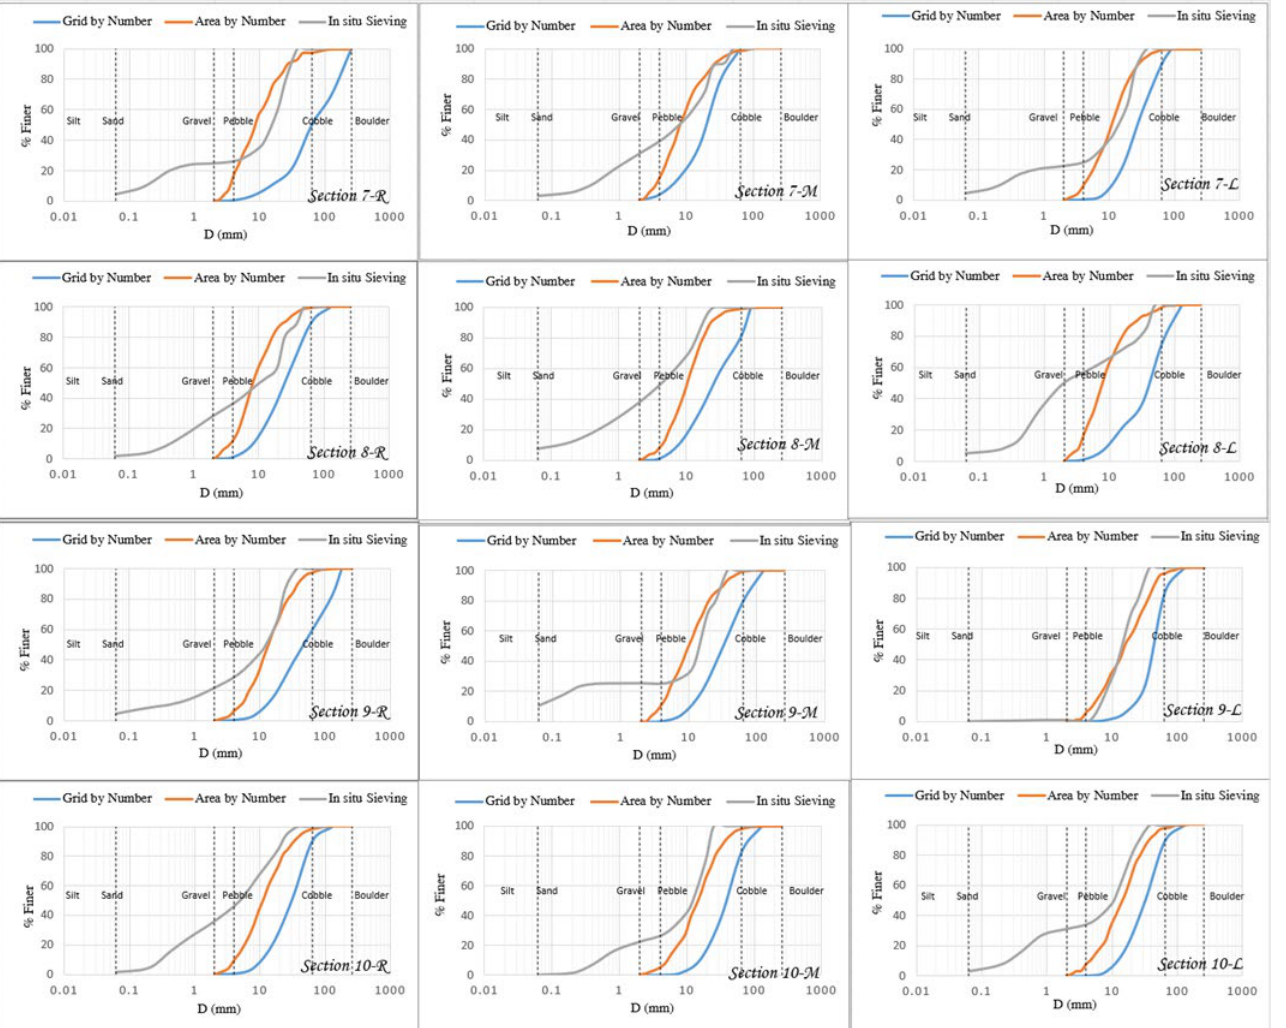
Figure 8. The grain size distribution curves acquired at observation points (Right, Middle, and Left) at each cross section through the photogrammetric technique (area by number, grid by number) and through the sieve analysis method.